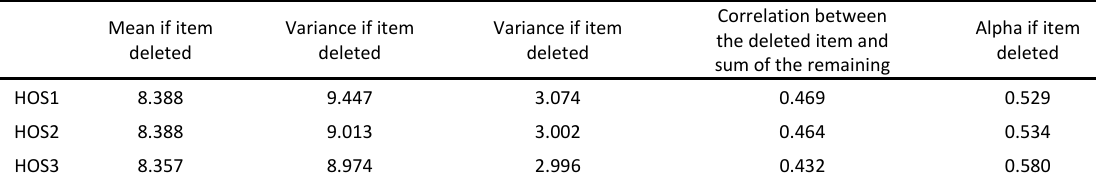
Table 3: Summary of HOS scale